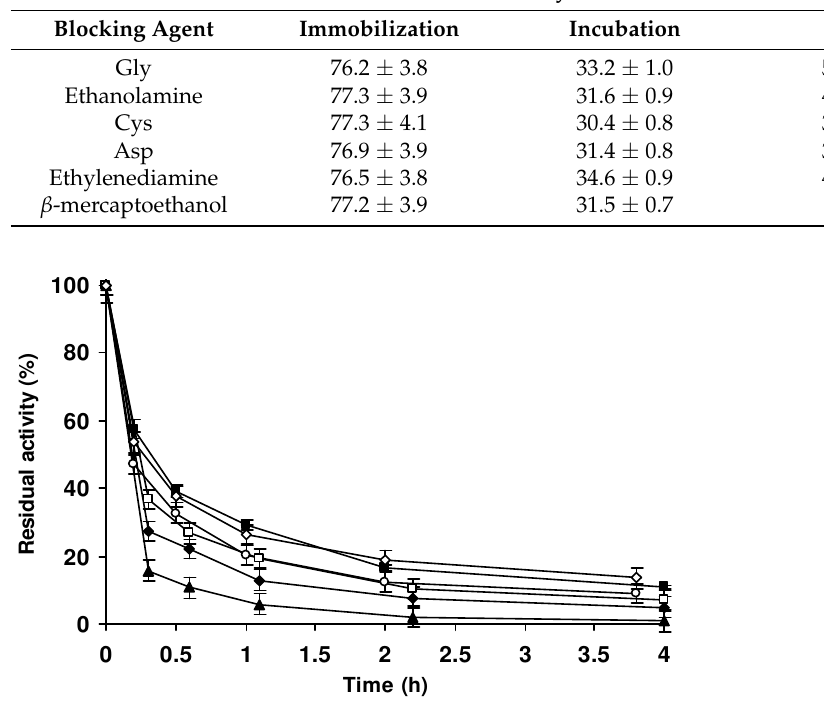
Figure 7. Effect of the blocking agent in the thermal inactivation courses of PGA biocatalysts immobilized at pH and incubated at pH 10.0 for 5 h (see Table 5 for further details). Full squares: glycine. Empty squares: cysteine. Full triangles: ethylenediamine. Empty circles: aspartic acid. Full rhombi: ethanolamine. Empty rhombi: β -mercaptoethanol. Other specifications are described in the Methods Section.